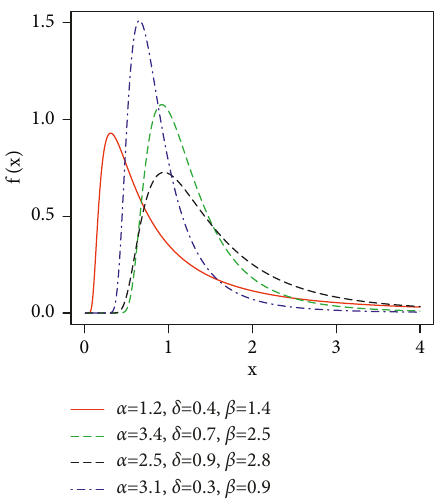
Figure 2: Different plots r ( x ; β , ψ ) of the FRL-IW